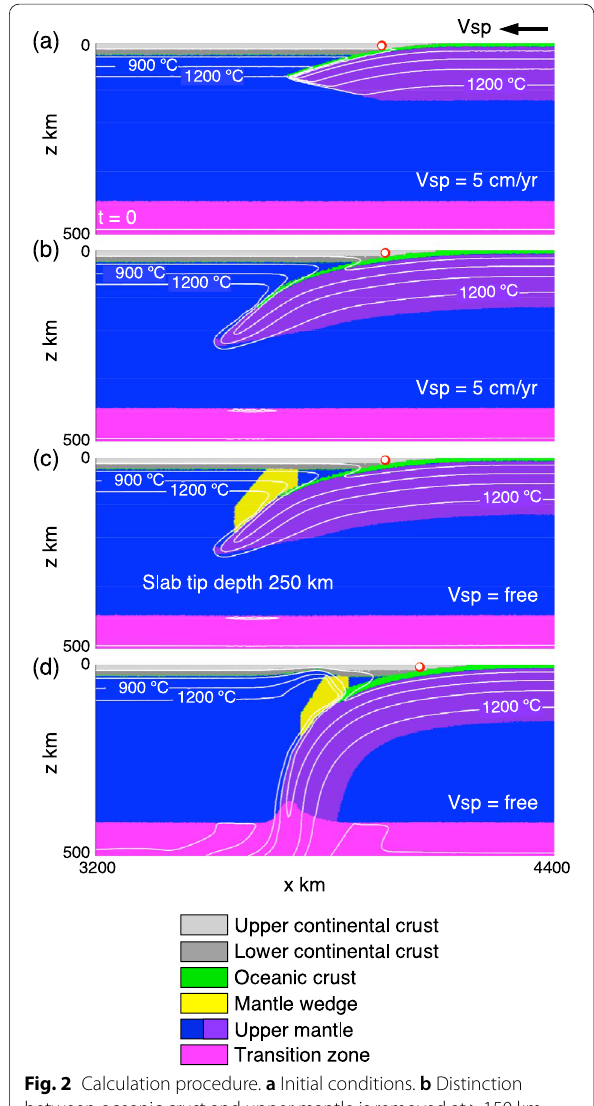
Fig. 2 Calculation procedure. a Initial conditions. b Distinction between oceanic crust and upper mantle is removed at > 150 km depth. c When the slab tip reaches a depth of 250 km, (1) area of mantle wedge (bounded by the slab surface, a horizontal range between the location of the slab surface at depths of 80–200 km and depths z > 30 km) is replaced by materials with lower viscosity and density, and (2) the frictional properties for mantle and crust above the mantle wedge are decreased to c 1 MPa and φ φ AL . After this = = time, (3) the depth where oceanic crust is no longer distinguished from mantle is changed to 100 km, and (4) the subducting plate is free to move in response to the underlying dynamics. d Geometry of the mantle wedge changes according to the calculated slab geometry. A red circle indicates the position of the marker used to measure trench velocity ( V tr